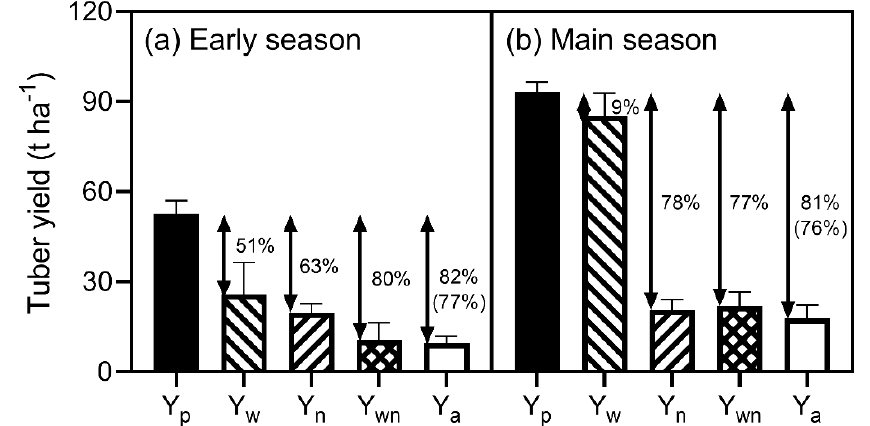
Figure 4. Simulated and reported yields of the early ( a ) and main ( b ) season potatoes (Y p , potential yield; Y w , water-limited yield; Y n , nitrogen-limited yield; Y wn , water- and nitrogen-limited yield; Y a , reported yield). Arrows indicate yield gaps from Y p . For Y a , exploitable yield gaps (yield gap from 0.8 × Y p ) are indicated in parentheses. Error bars indicate standard deviation over the years.